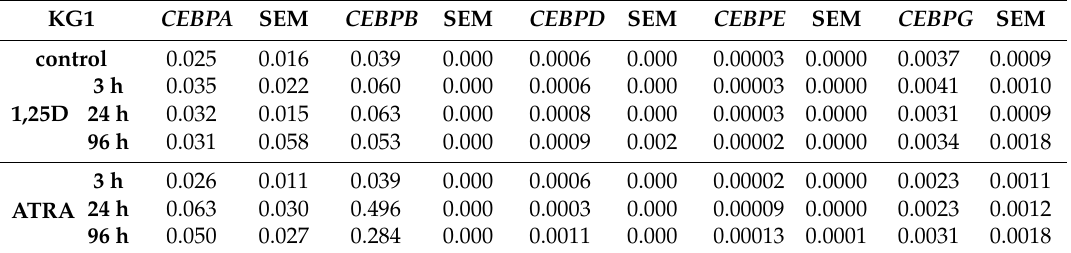
Table A2. Comparative quantification of CEBP genes related to a reference GAPDH gene in KG1